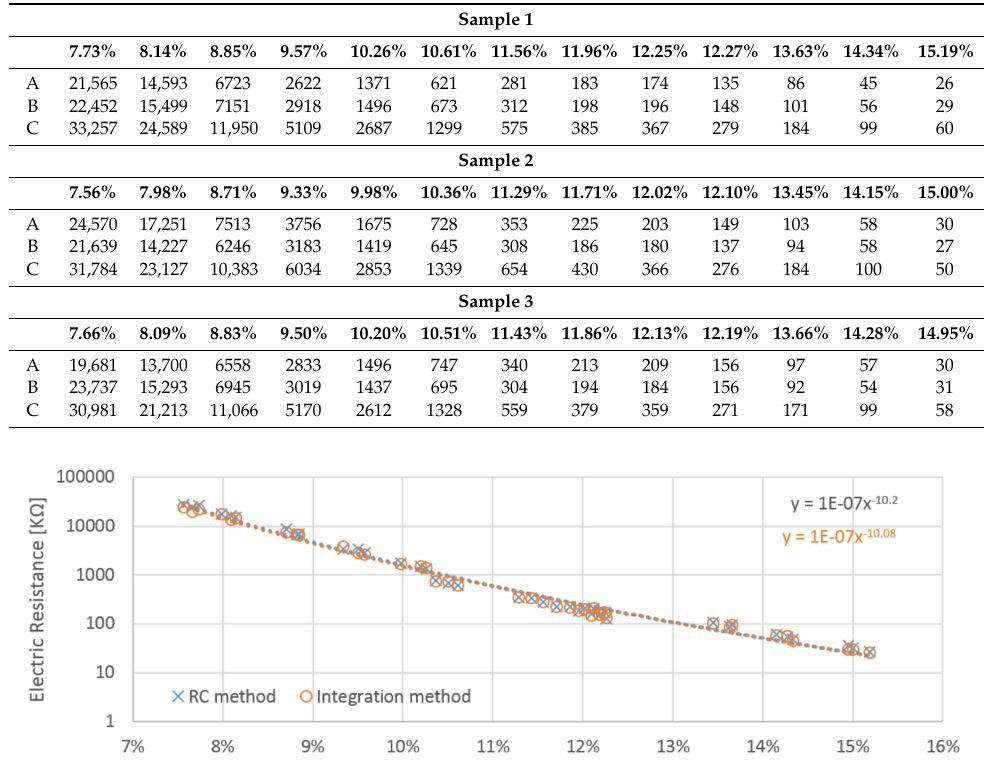
Table 2. Calculated resistances from the integration method in MOhm.